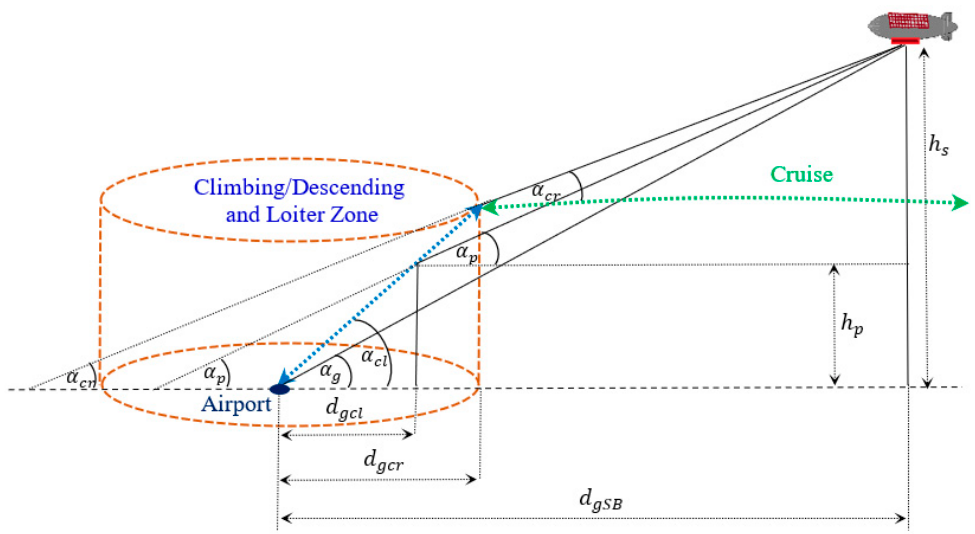
Figure 9. Geometrical model for calculation of atmospheric attenuation profile during flight.